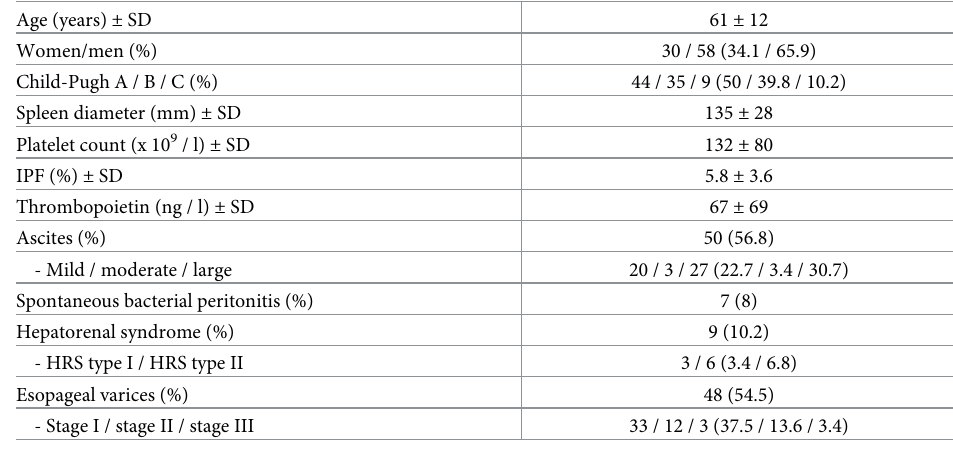
Table 1. Patient